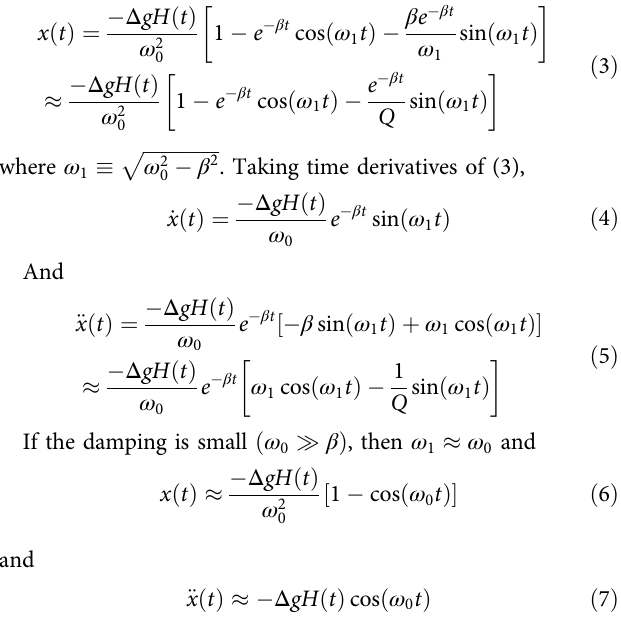
Where T R (cid:4) 4 R = c s , R is the hypocentral distance and c S is the shear wave velocity. If the gravity signal is changing with time as Δ g t ð Þ , then the expected gravimeter signal is